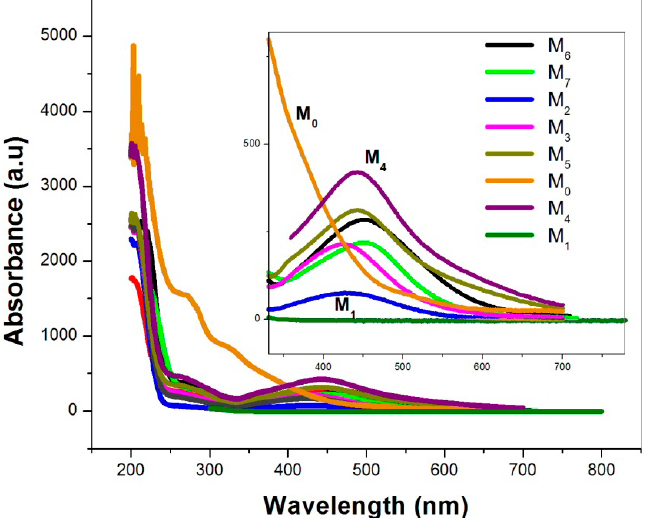
Figure 3. UV-Vis spectra of AgNO3 solution (M1), Mulberry extract (M0) and AgNps prepared at different Mulberry leaves extract.